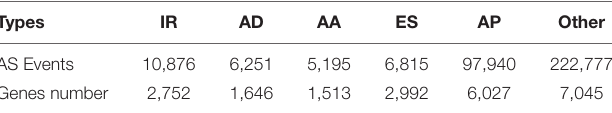
TABLE 2 | Classification of alternative splicing (AS)